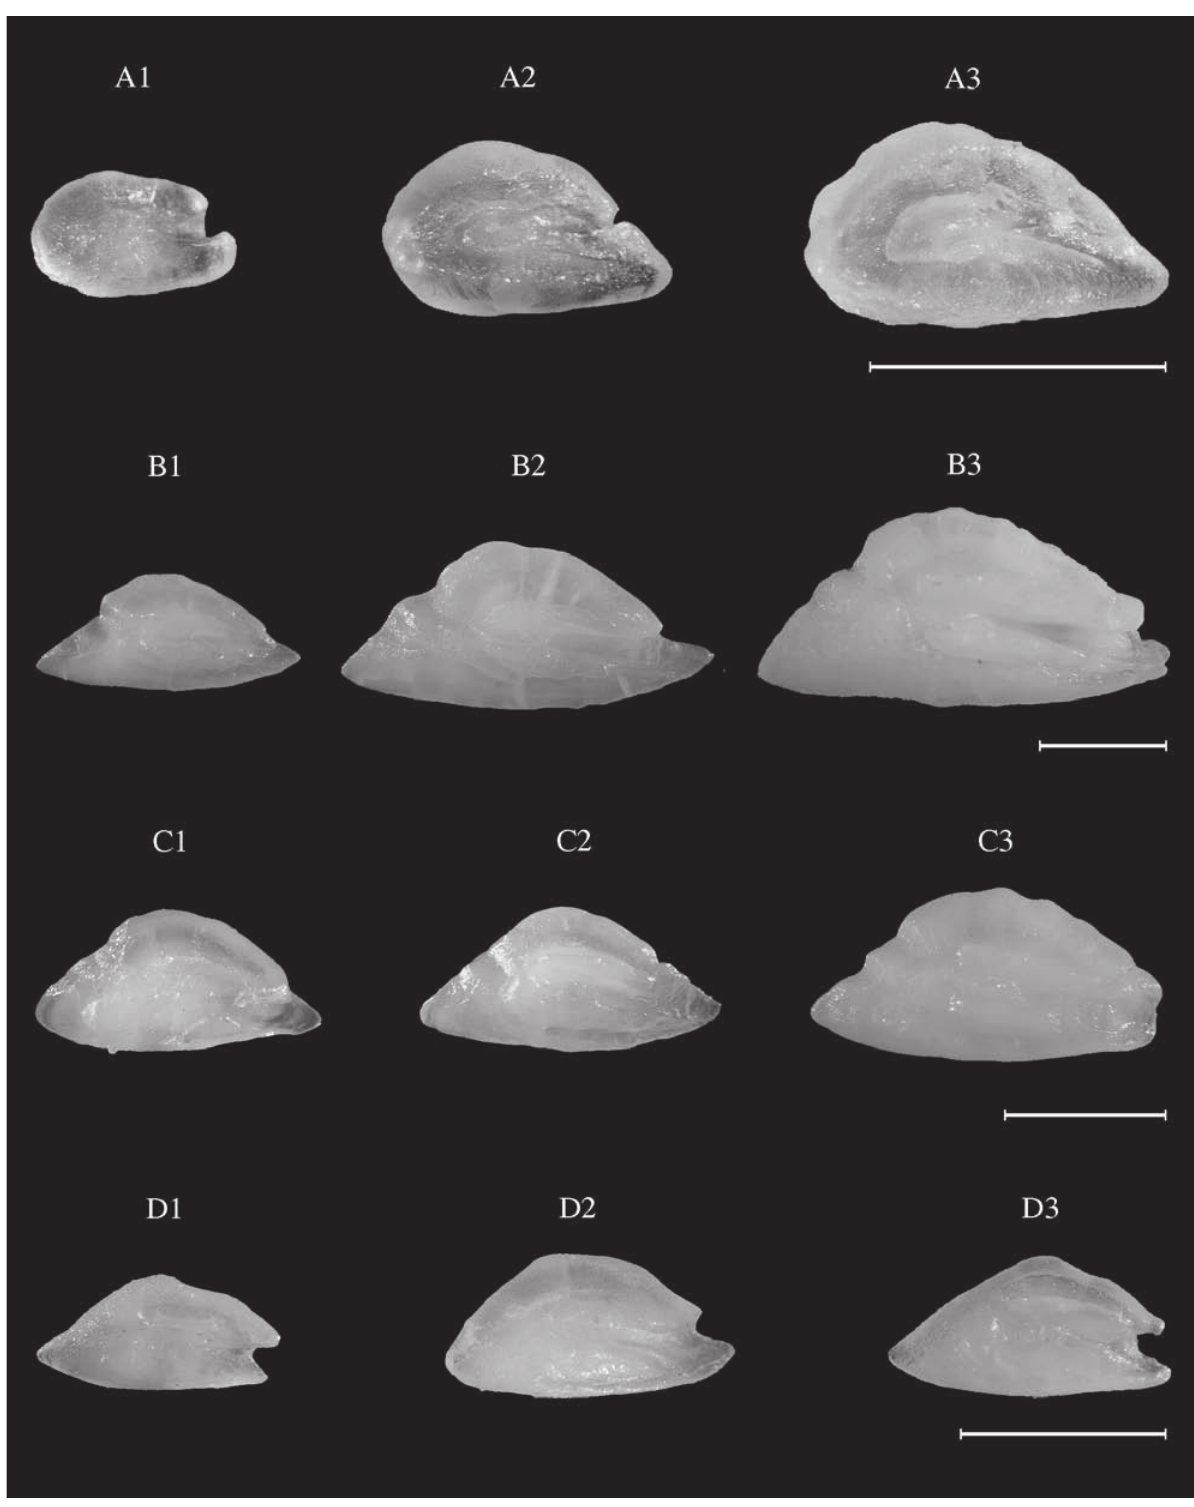
Fig. 78. – Lepadogaster purpurea (NEA) . TL: A1, 4.6 cm; A2, 6.0 cm; A3, 7.8 cm. Callionymus lyra (NEA) . TL: B1, 10.1 cm; B2, 16.0 cm; B3, 23.5 cm. Callionymus maculatus. TL: C1, 7.5 cm (WM); C2, 9.6 cm (NEA); C3, 11.3 cm (NEA). Callionymus risso. TL: D1, 6.3 cm (NEA); D2, 6.5 cm (WM); D3, 7.2 cm (NEA). Scale bar = 1